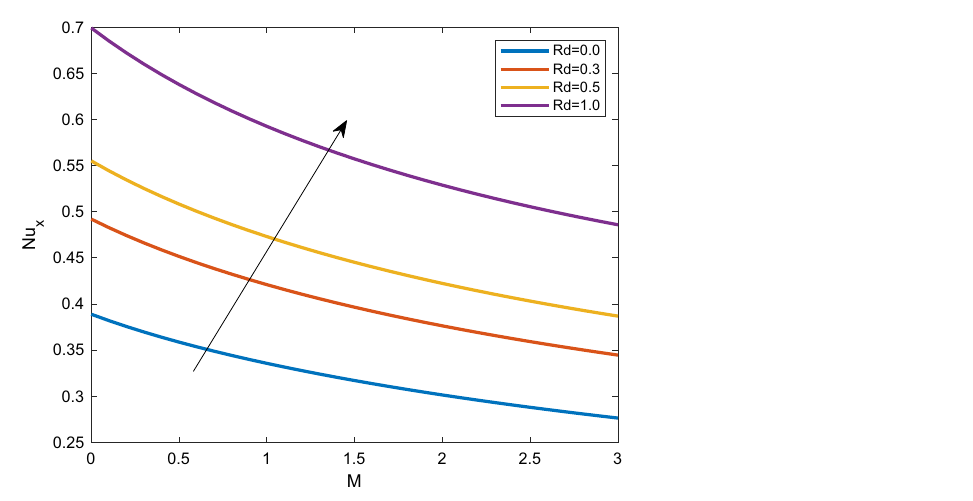
Figure 13. Effect of Rd on heat